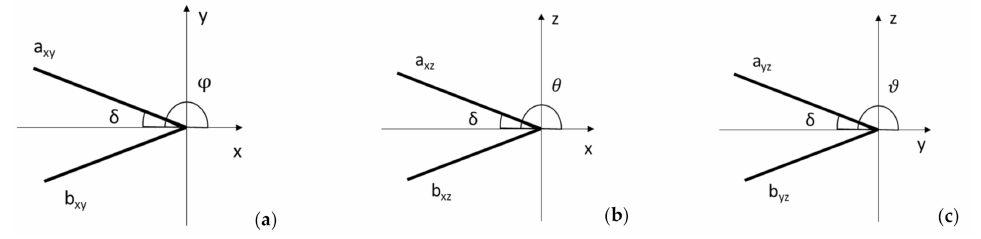
Figure 2. Safety corridor constraints: ( a ) xy plane, ( b ) xz plane, ( c ) yz plan.